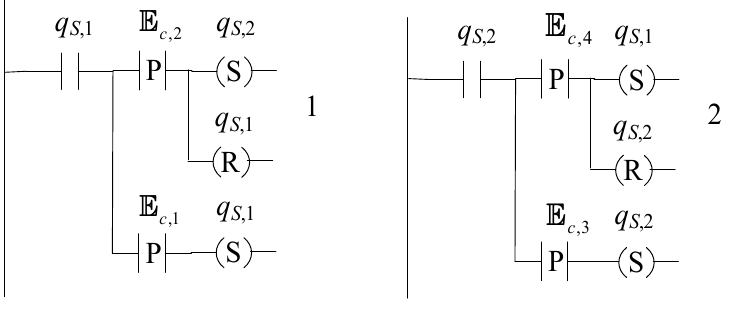
Figure 7. Ladder diagram of S .